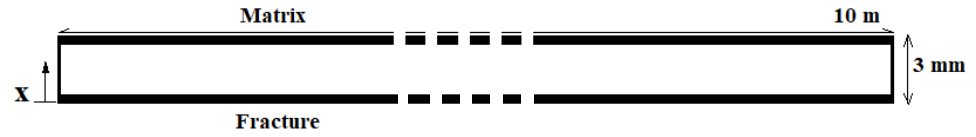
Figure 1. The 2D simulation domain setup, length of 10 m and width of 3 mm with pore size varying along the x- direction.